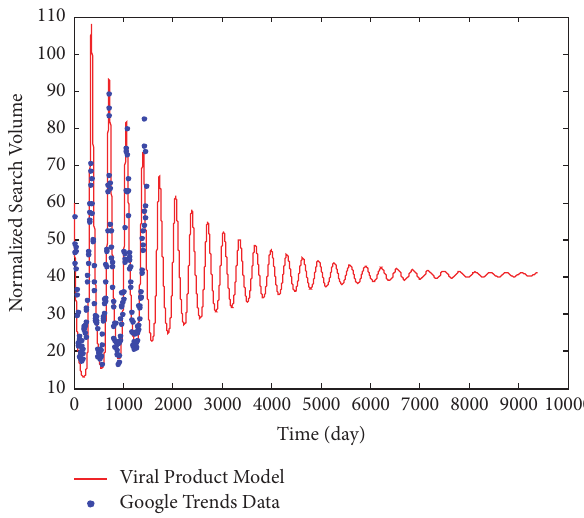
Figure 7: The solution of viral product diffusion model will tend to the equilibrium